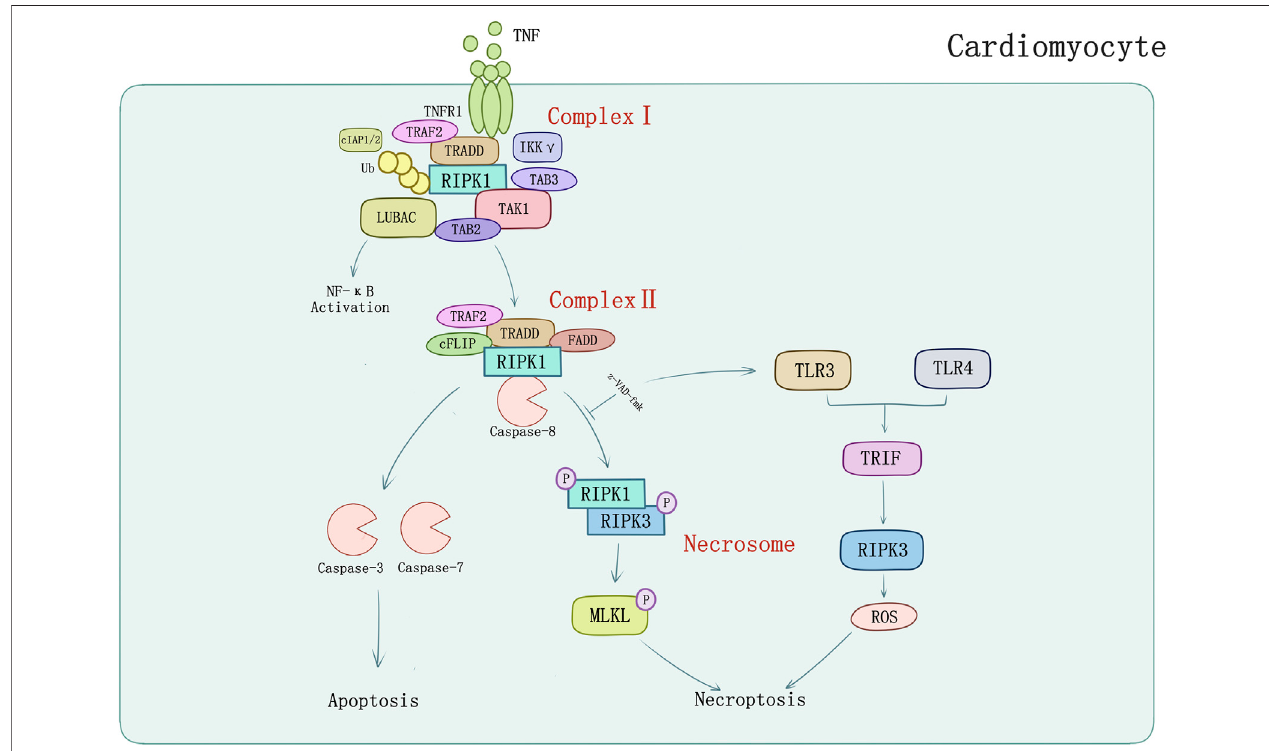
FIGURE 1 | TNFR1-mediated apoptosis and necroptosis in cardiomyocyte. TNF- α binds with TNFR1 to transmit in fl ammatory signal into cells, and then induces formation of complex I consisting of TRADD, TRAF2, RIPK1, cIAPs, LUBAC, etc. Activated complex II induces caspase-dependent apoptosis which could be inhibited by pan-caspase inhibitor z-VAD-fmk. Z-VAD-fmk could also induce TLR3/TLR4-mediated signaling pathways and TRIF which induces RIPK3-mediated necroptosis through ROS.